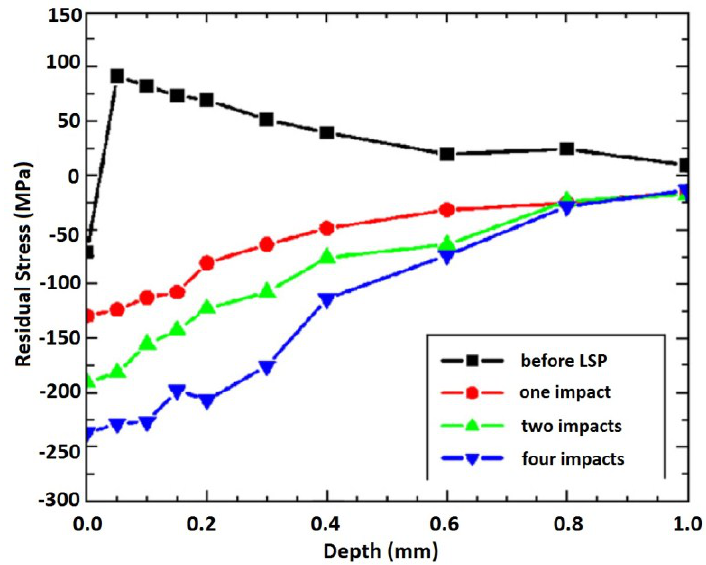
Figure 9. Residual stress (σ x ) variation with depth in AZ31B Mg alloy after different number of laser impacts